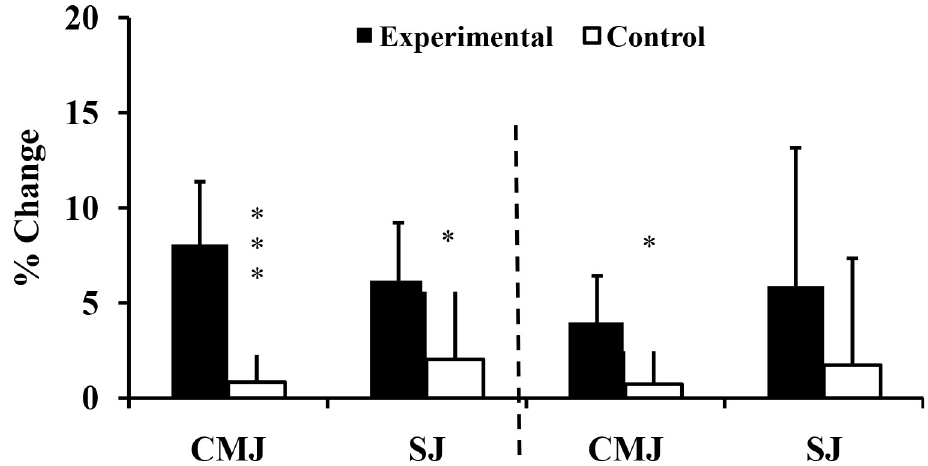
1 : after 10 weeks of resistance training; T 2 : after 2 weeks of tapering; CMJ: Counter-movement Jump; SJ: Squat Jump; � : ANOVA group x time interaction significantly different between E and C at the level of p < 0.05; ��� : ANOVA group x time interaction significantly different between E and C at the level of p < 0.001.